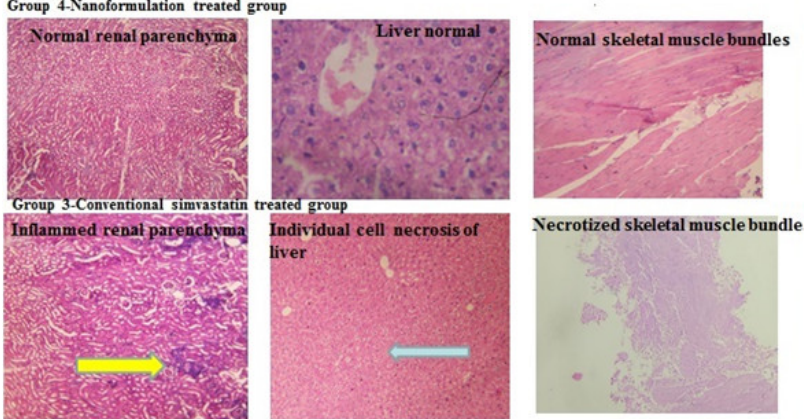
Figure 10. Comparative histopathology photographs of groups 3 and 4 representing reduced tox- icity of group 4 (formulation